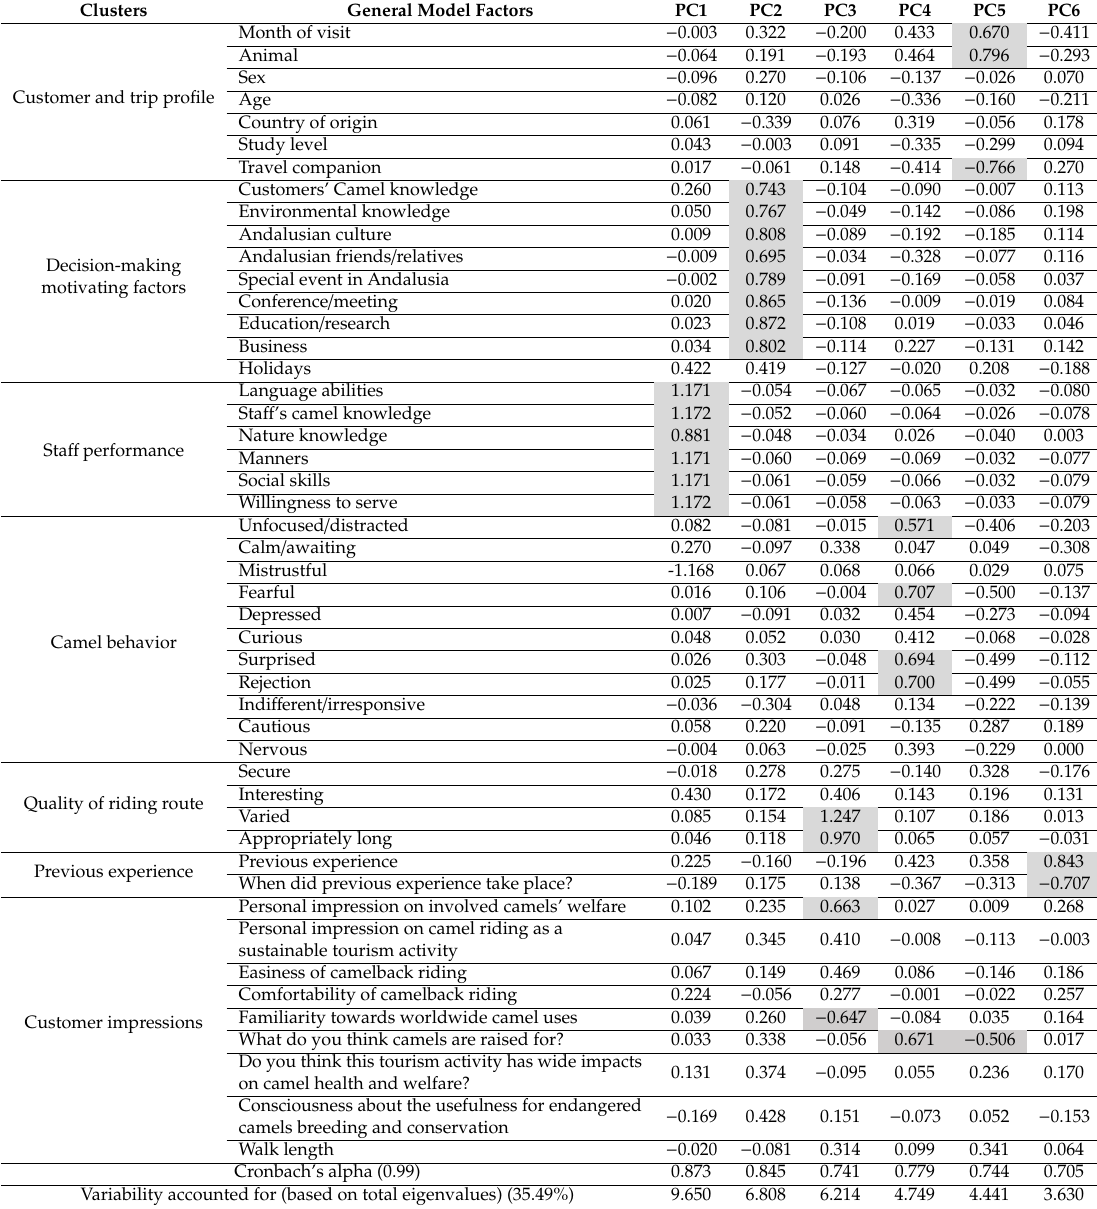
Table 3. Summary of general model clusters and factors that each cluster comprised and Varimax with Kaiser normalization rotated component loadings for each of these